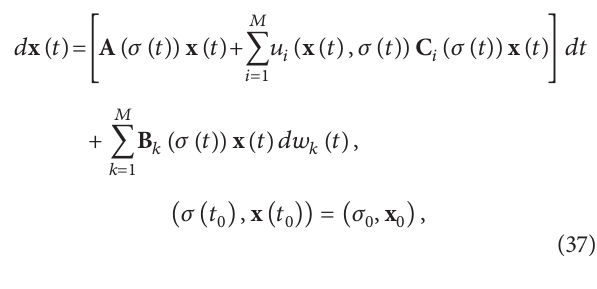
together with the stabilizing switching rule 𝜎 st ∈ SW renders the null solution of the stochastic hybrid system (27) the 𝑝 th mean exponentially